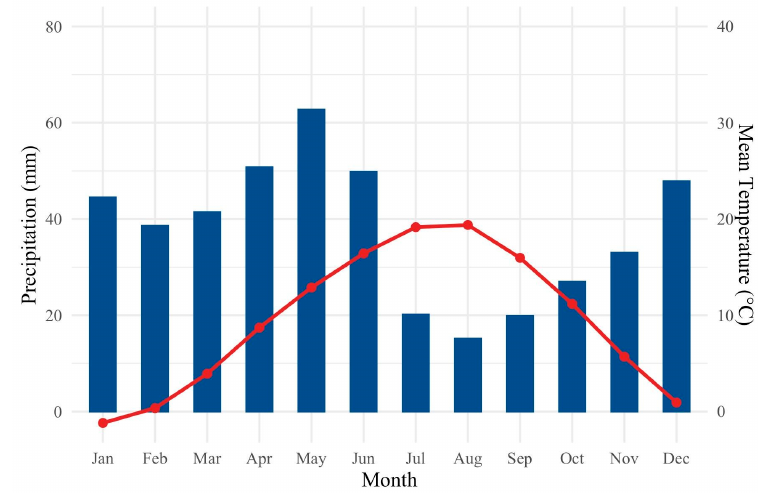
Figure 2. The lower KRB basin climatic diagram. It was drawn using the CRU TS4.04 monthly total precipitation and mean temperature data of the lower KRB. Red line and bars represent mean temperature (°C) and precipitation (mm), respectively.